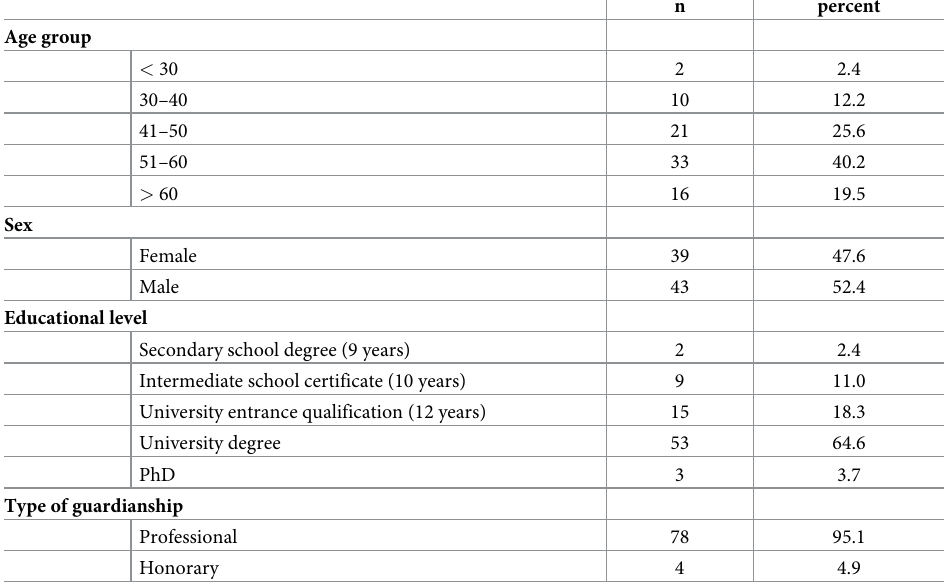
Table 1. Characteristics of legal guardians (n =